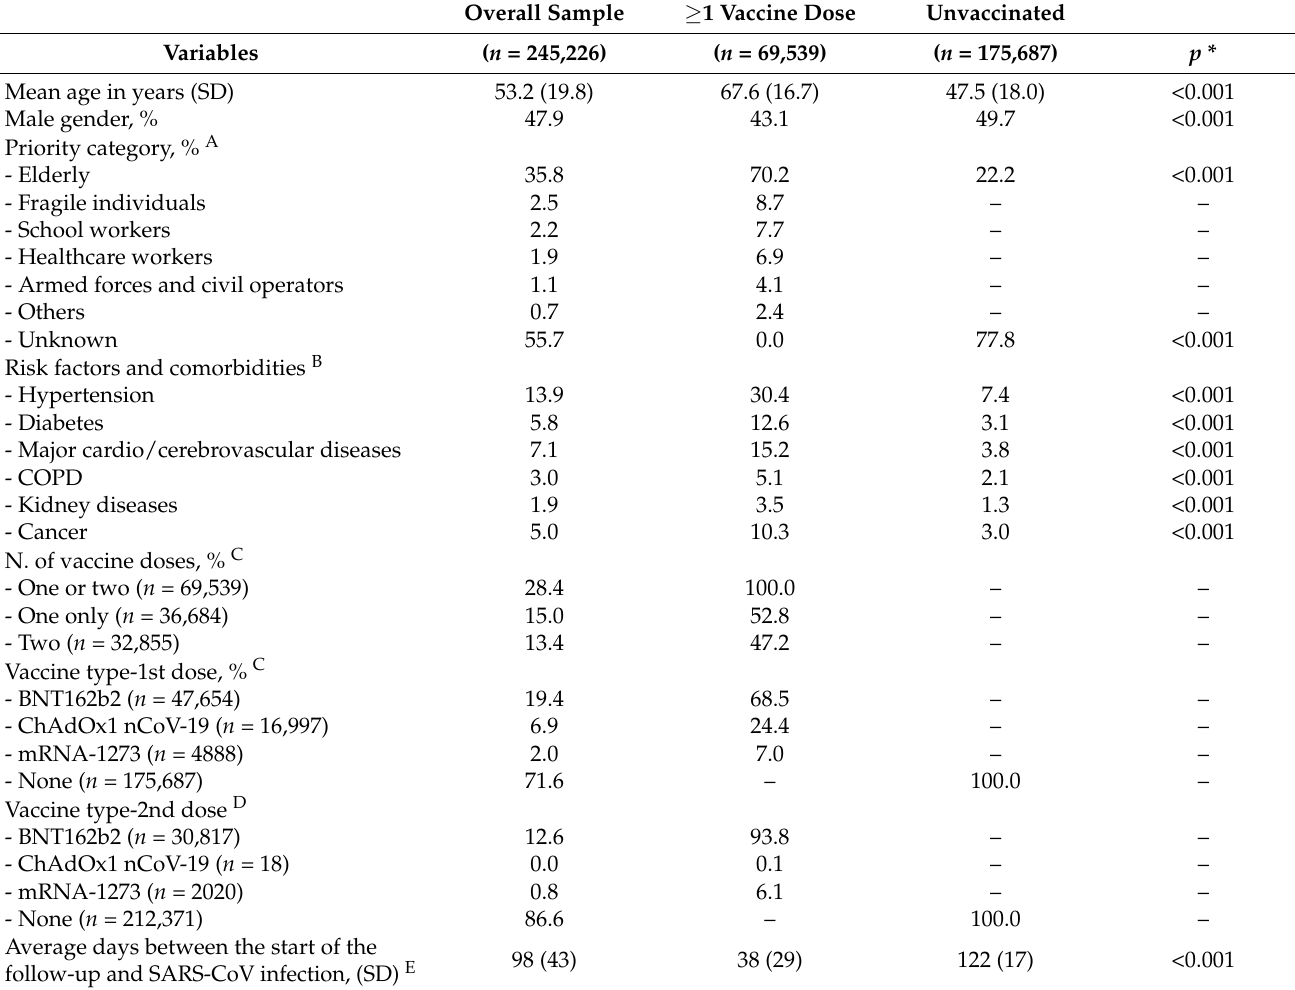
Table 1. Main characteristics and outcomes of the sample, overall and by vaccine status. Overall Sample ≥ 1 Vaccine